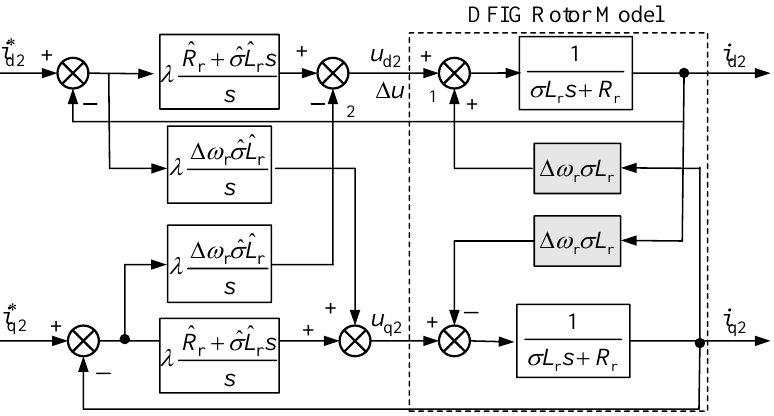
length of the paper, the corresponding discussion will not be carried out.